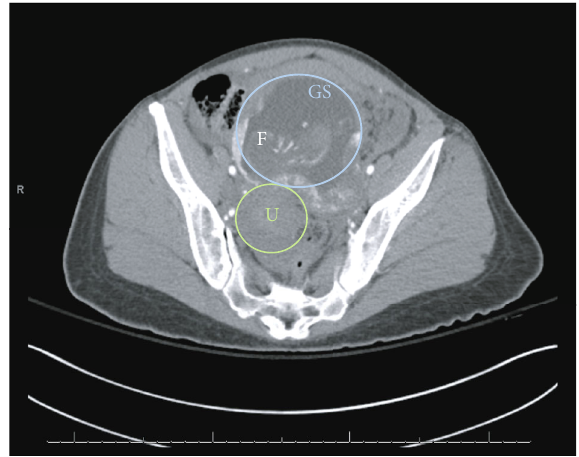
Figure 4: CTA showing fetal structures (F) within a gestational sac (GS) anterior to the uterus